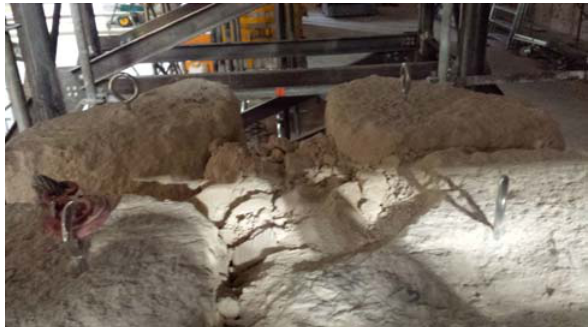
Figure 8. Top images of a pillar during the disassemble step; in the centre, the irregular mortar core of the column.